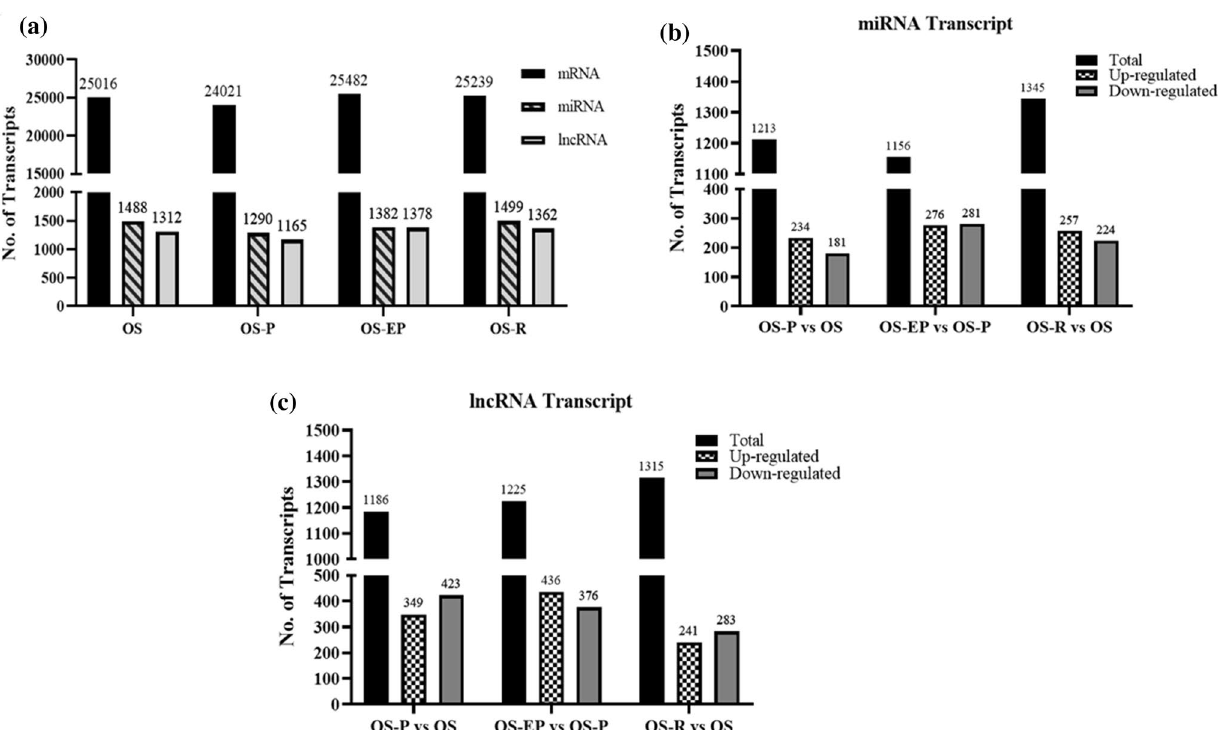
Fig. 1 Overall coding and noncoding transcriptomic profile in OS cells. a Distribution of different RNA transcripts for untreated parental OS cells (OS), persisters (OS-P), extended persisters (OS-EP) and resistant cells (OS-R). Comparative analysis of b miRNA and c lncRNA transcripts in the OS-P vs. OS, OS-EP vs. OS-P and OS-R vs. OS sets. The term ‘Total’ indicates the total number of transcripts expressed in the comparison sets, including upregulated, downregulated or neutrally regulated